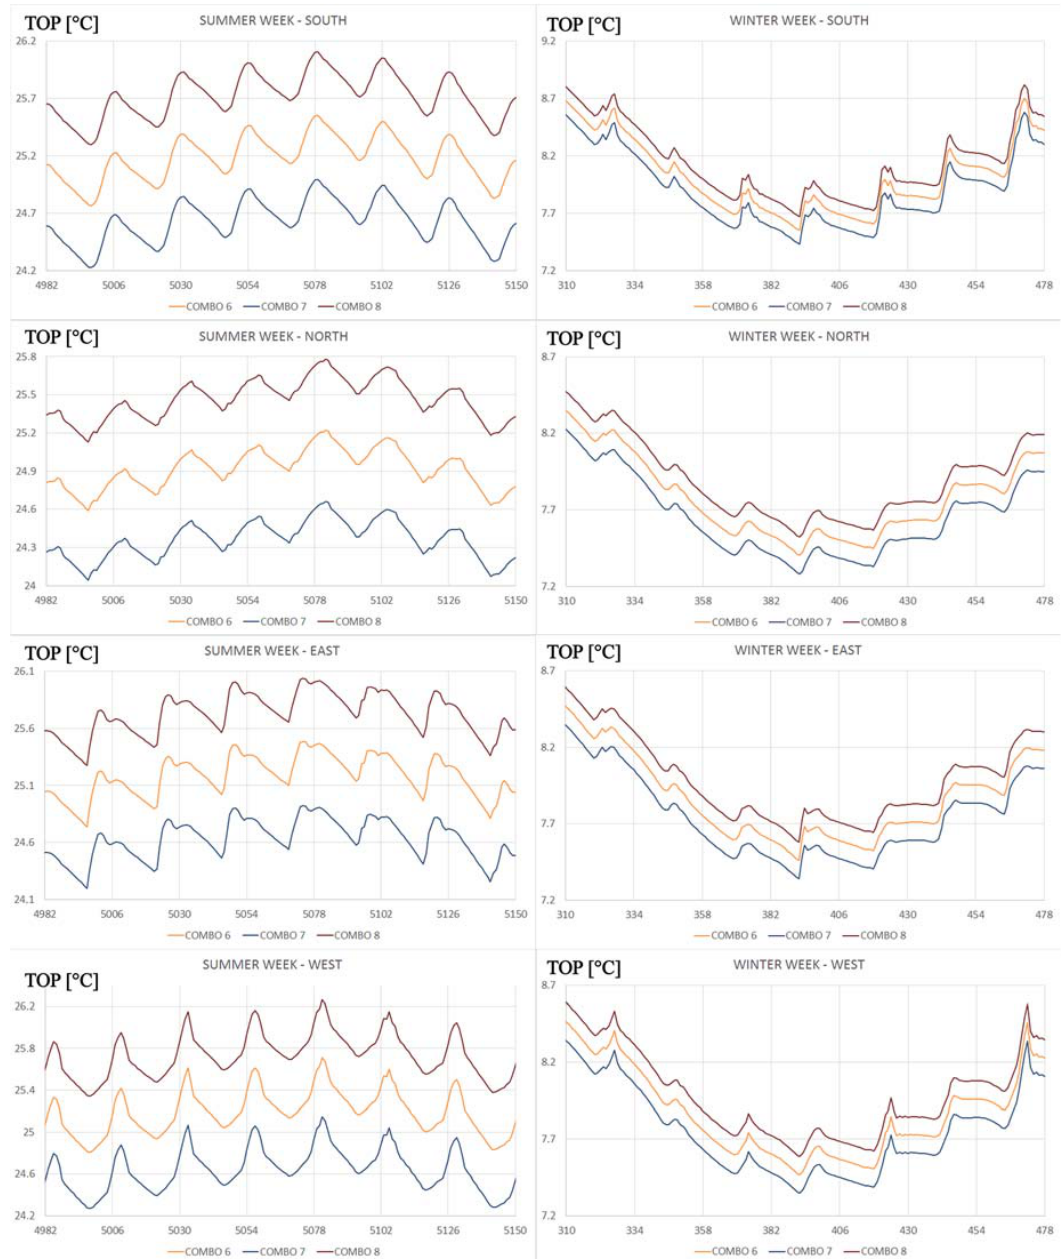
Figure 6. TOP graphical trend for the STEP 3 (27 July–2 August; 12 January–18 January).